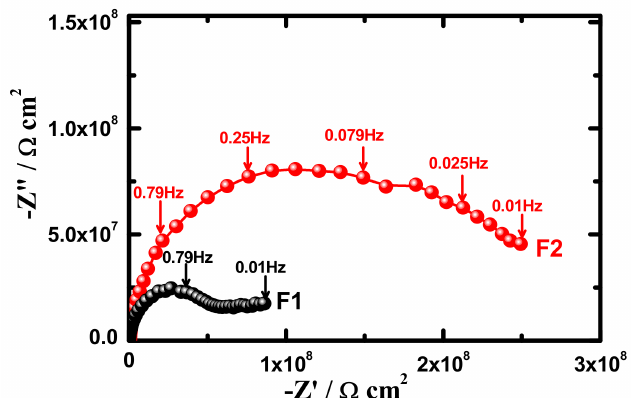
Figure 8. Nyquist plots for coatings F1 and F2 after 15 days’ immersion in the 3.5% NaCl solutions.